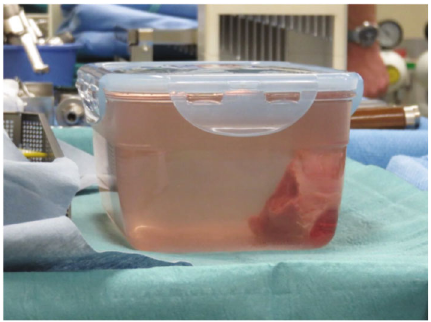
Figure 8: Picture of the specimen after curettage and placement in a physiologic serum fi lled sterile container ready to be wrapped and transported to the radio-oncology department for